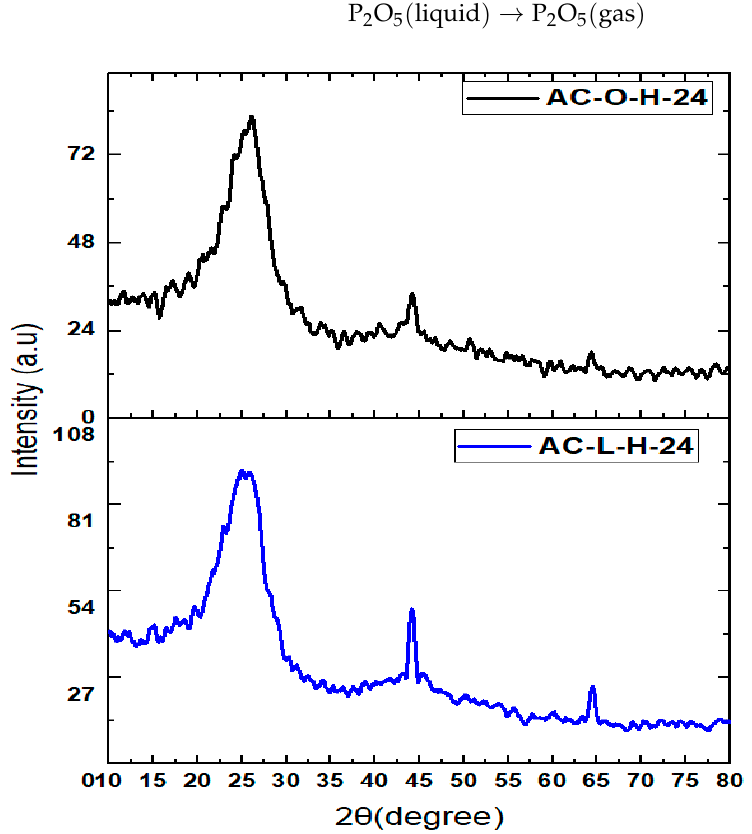
Figure 3. XRD analysis of activated carbon olive trees and Lantana camara